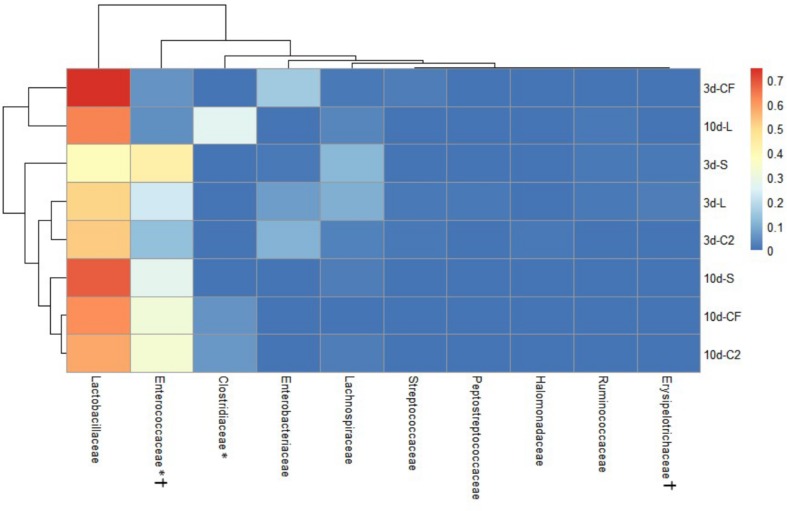
Dual hierarchical dendrogram based upon the predominant bacterial families identified in lower ileum microbiota of broilers treated with either saline (S), LAB-probiotic (L), Citrobacter freundii (CF) or Citrobacter spp. (C2). The taxonomic association of bacterial families is represented in the columns. Hierarchical clustering in the rows is based on composition similarity between treated samples. Heatmap plot represents the mean relative percentage of each bacterial family within samples. Statistical differences (P < 0.05) between groups were reported for each bacterial population (†) by 3 days of age and (∗) 10 days of age.